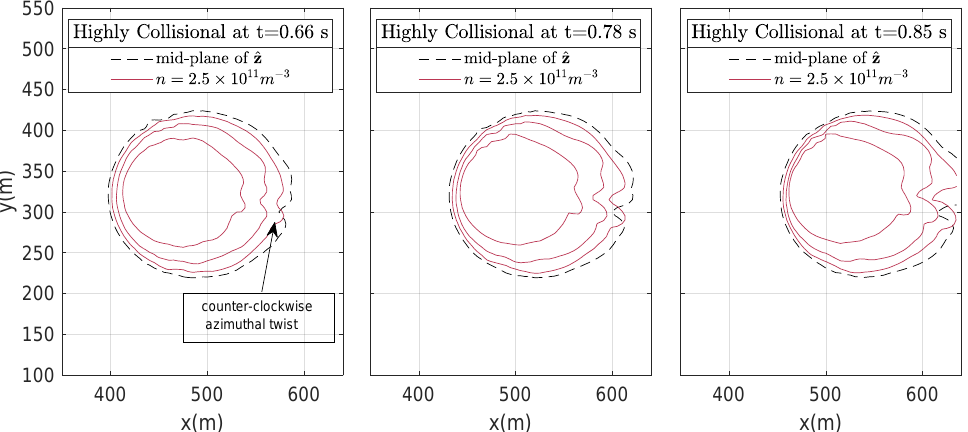
Figure 10. Early time evolution of contour plots of different latitudes above the mid-plane of ˆ z at a single density value, showing the highly collisional regime (i.e., ν in = 29.6 Hz) with a counter- clockwise azmithal